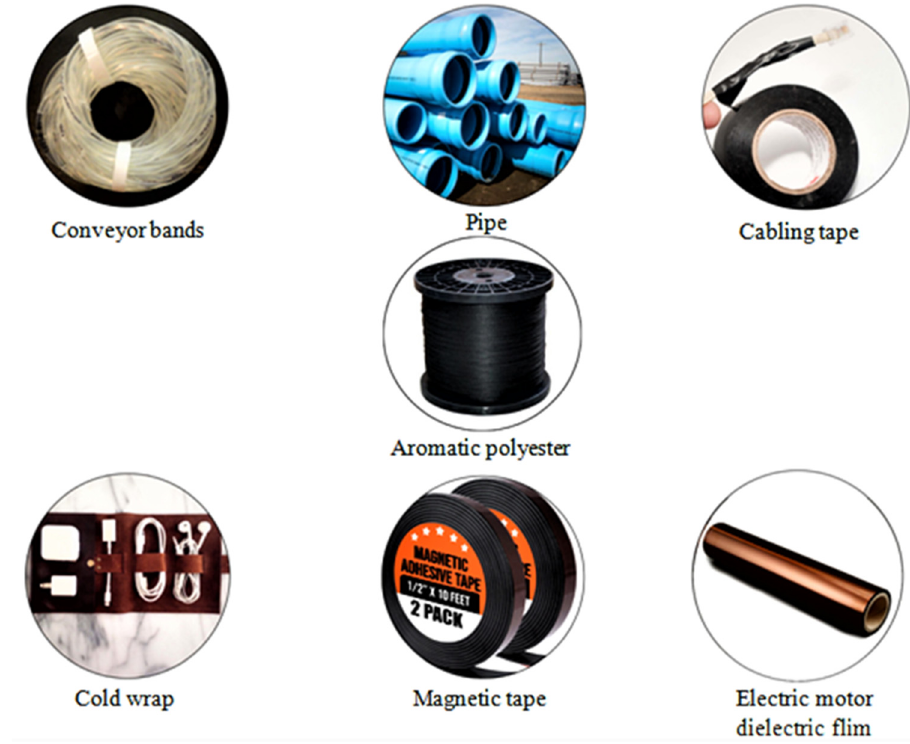
Figure 7. Application related to the aromatic polyester fiber in various sectors [63,64].